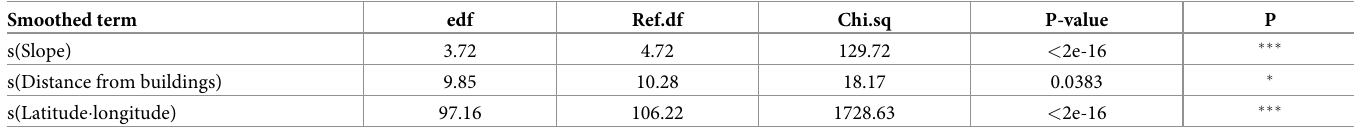
Table 3. Summary of the Generalized Additive Model (GAM) used to assess the effects of slope and distance from buildings on the number of GPS locations, counted within sample units at farm scale. Smoothed term